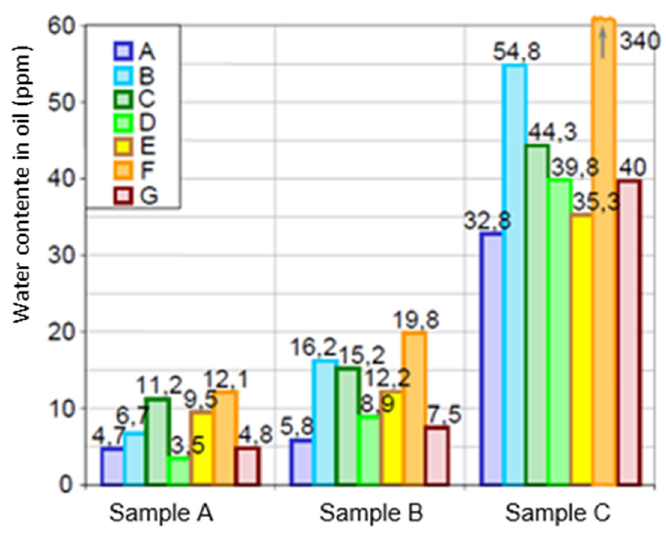
Figure 37. Several laboratories carried out measurements of water content in oil